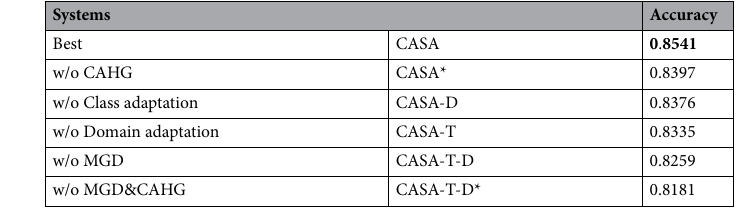
Table 4. Ablation study results. For all transfer learning models, the source domain is virus. w/o CAHG means removing the sentence nodes and intergraph token-token links and turning them into a homogeneous graph structure for training. Accuracy is reported as the average result over 5 runs with random